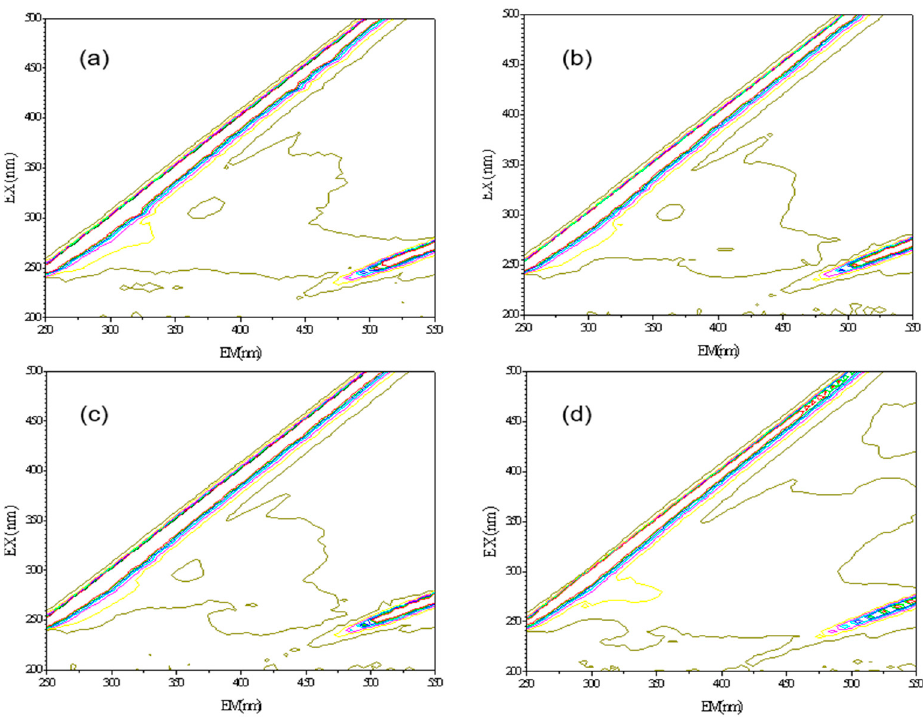
Figure 4. 3D-EEM atlas of EPS. ( a – d ) Speed of 0 rpm, 50 rpm, 80 rpm and 120 rpm, respectively.